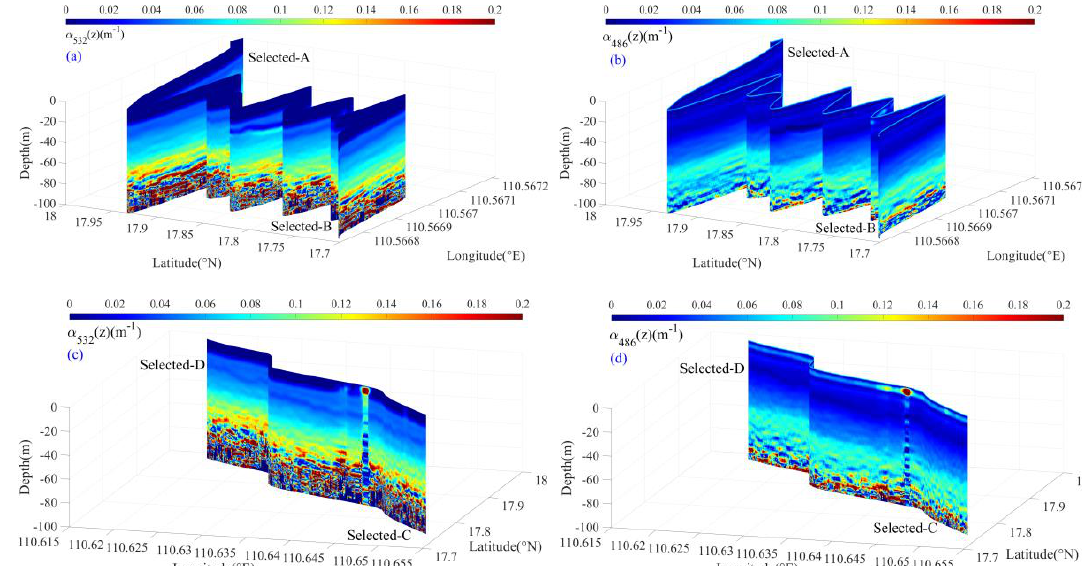
Figure 19. ( a ) Distribution of α 532 ( z ) from Selected-A to Selected-B; ( b ) distribution of from Selected-A to Selected-B; ( c ) distribution of α 532 ( z ) from Selected-C to Selected-D; ( d ) distribution of α 486 ( z ) from Selected-C to Selected-D. Value of α ( z ) limited from 0 to 0.2 for better